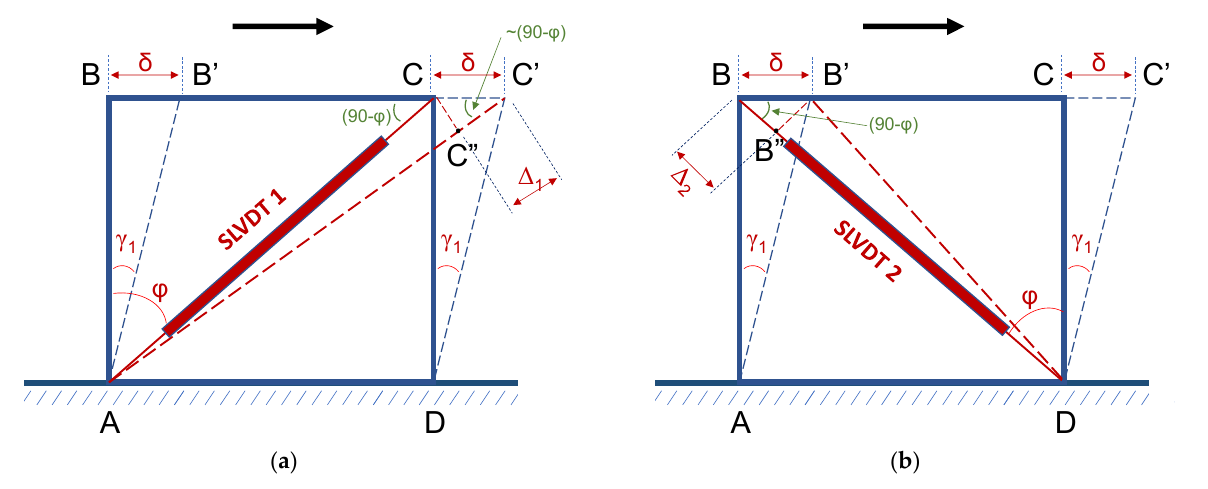
Figure 4. Elongation ( a ) and shortening ( b ) of the diagonals of the rectangular panel of the BCJ. Two diagonal SLVDTs were mounted on each specimen’s joint area to measure the elongation and the shortening of its diagonals at each loading step.